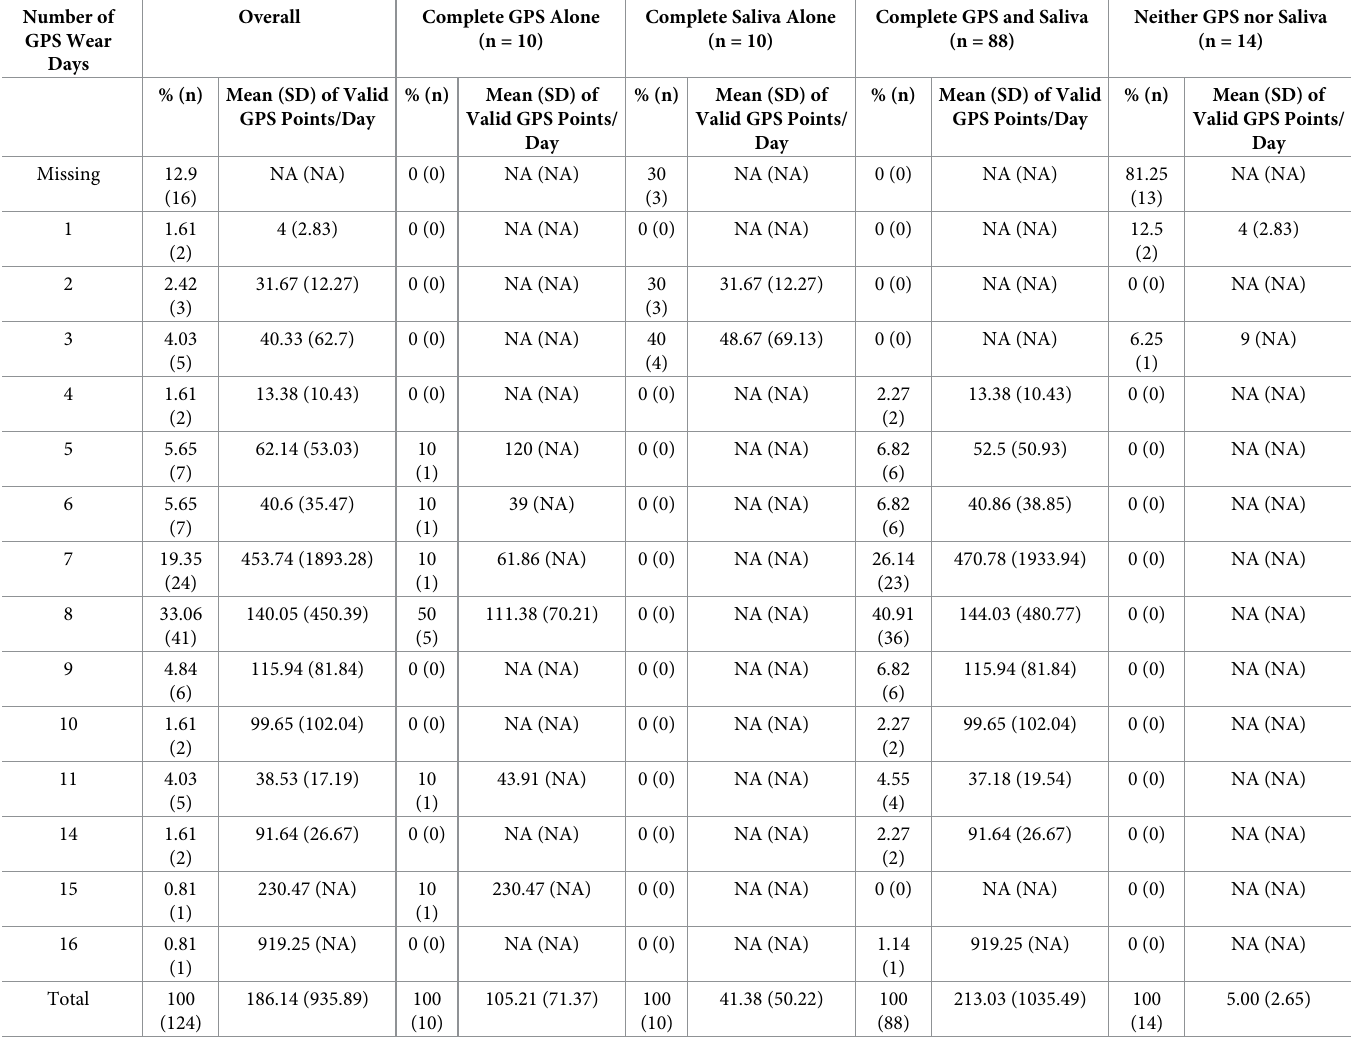
Table 4. GPS wear time and average daily valid GPS points by different types of data